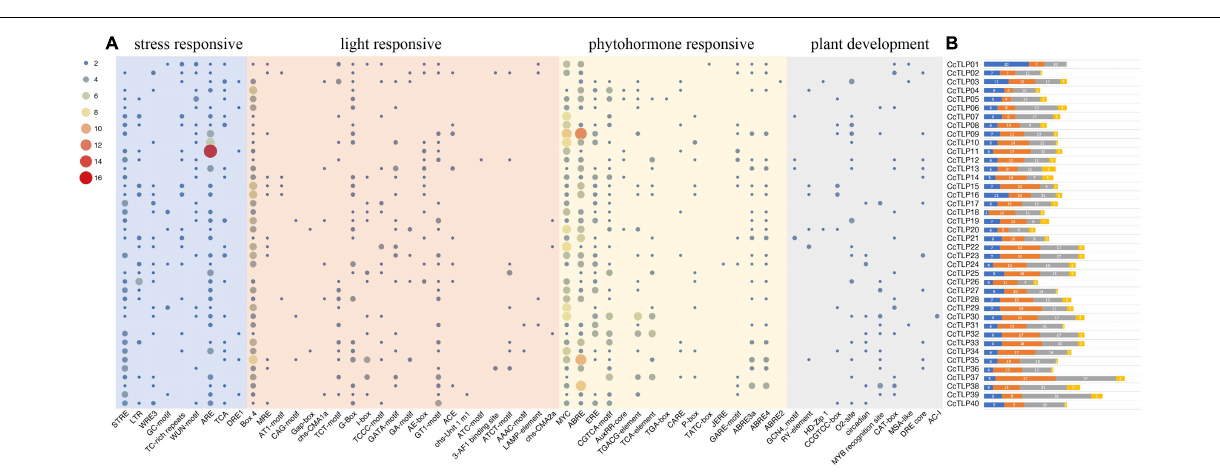
FIGURE 4 | The predicted Cis -acting elements distribution pattern in 40 CcTLP gene promoter regions. (A) These cis -acting elements were classified into four groups: stress-responsive, light-responsive, phytohormone-responsive, and plant-responsive, as shown in the heatmap. (B) The total count of these four categories is displayed in the bar plot. Blue: stress-responsive. Orange: light-responsive. Gray: Phytohormone-responsive. Yellow: